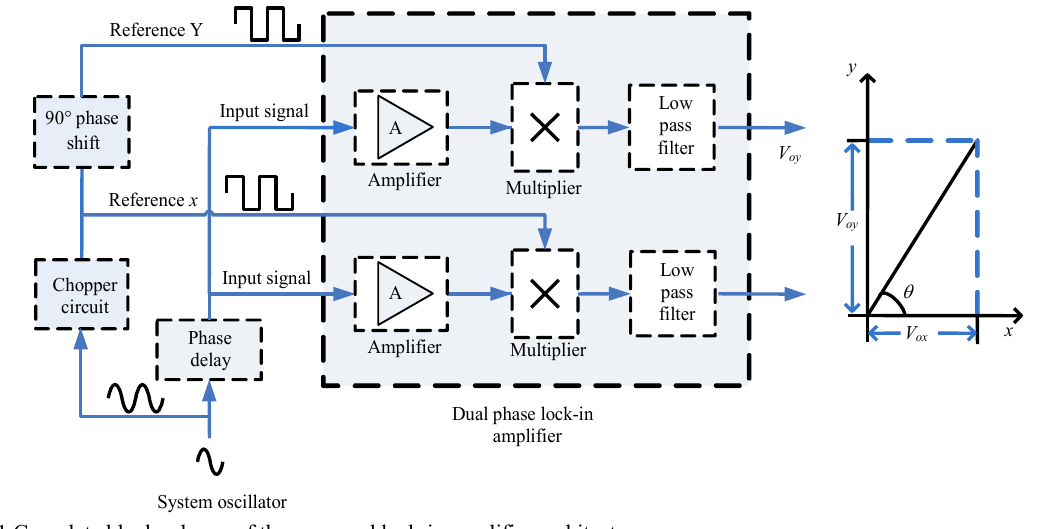
Fig. 1 Complete block scheme of the proposed lock-in amplifier